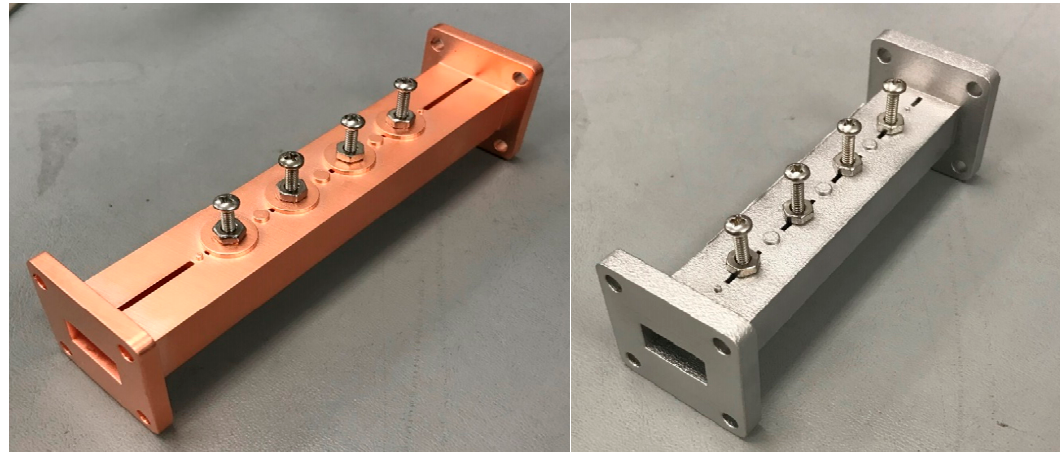
Figure 11. SLA 3D printed, copper plated and DMLS microwave bandpass filter.